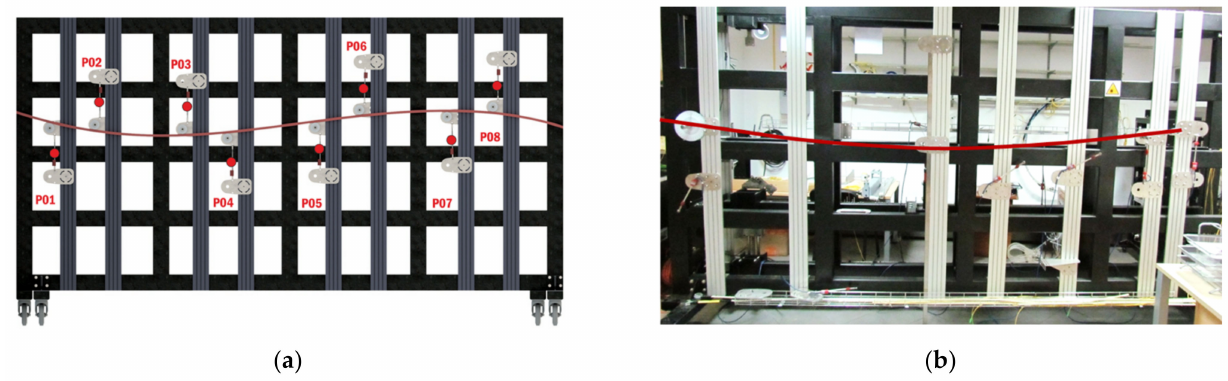
Figure 17. Steel frame as a part of measurement station: ( a ) design; ( b ) view in the laboratory.